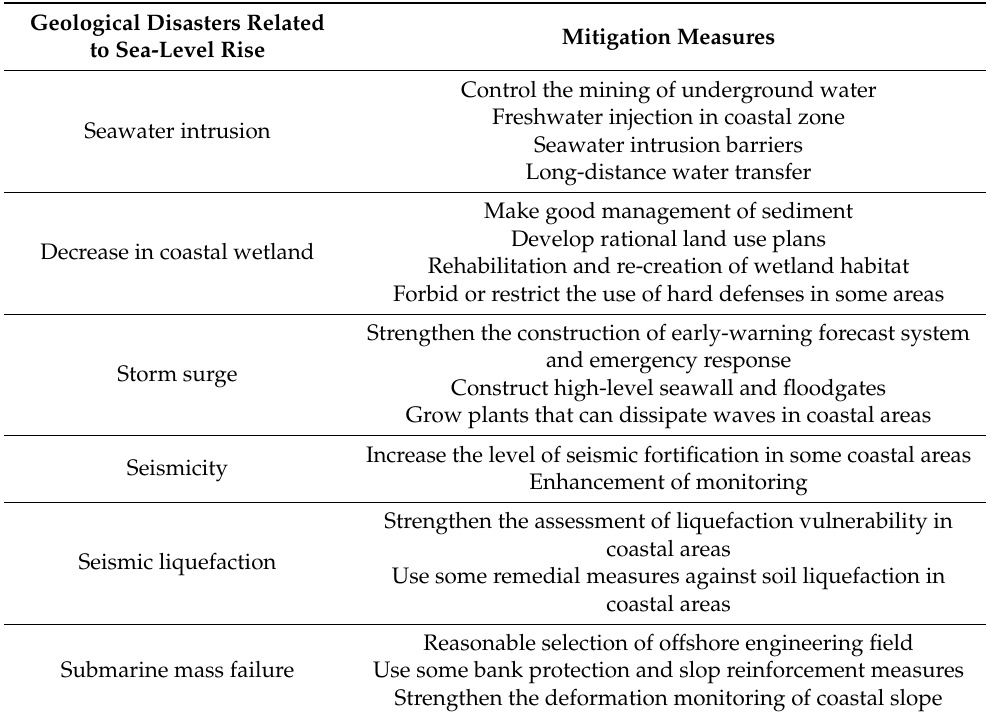
Table 1. Specific mitigation measures for different geological